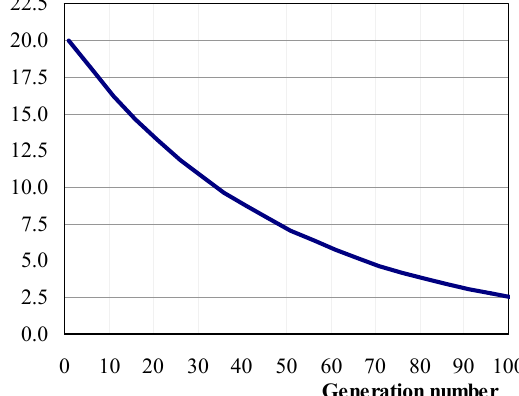
Fig. 11. Evolution of the prescribed value of γ .